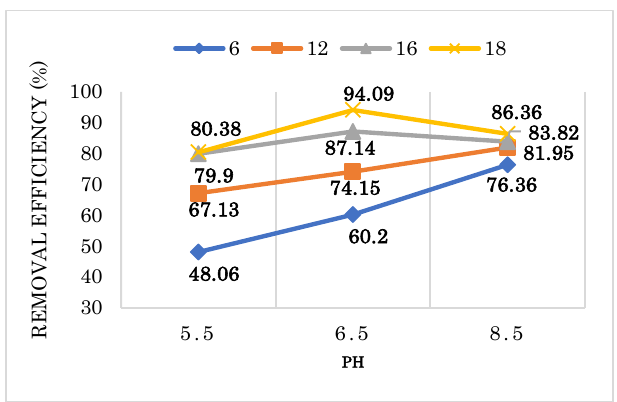
Fig. 6. pH optimization for turbidity removal for 3